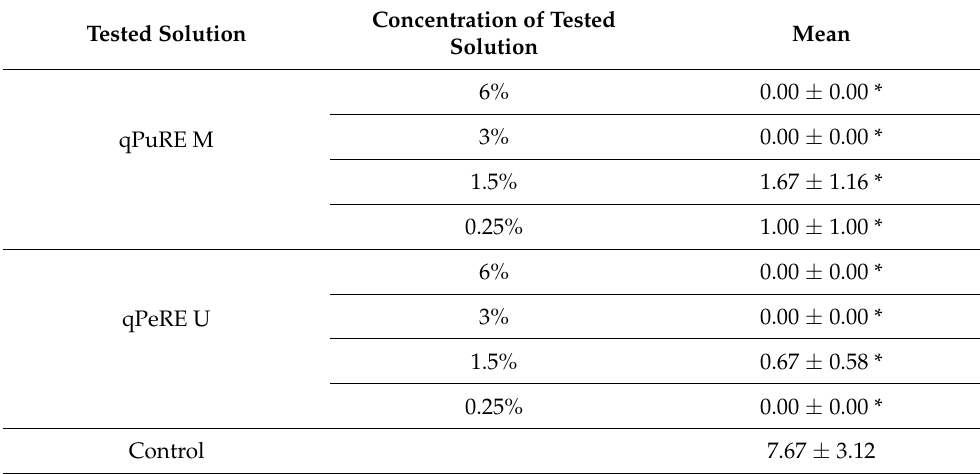
Table 3. The effect of tested solutions on confluent cells after 24 h of incubation. Tested Solution